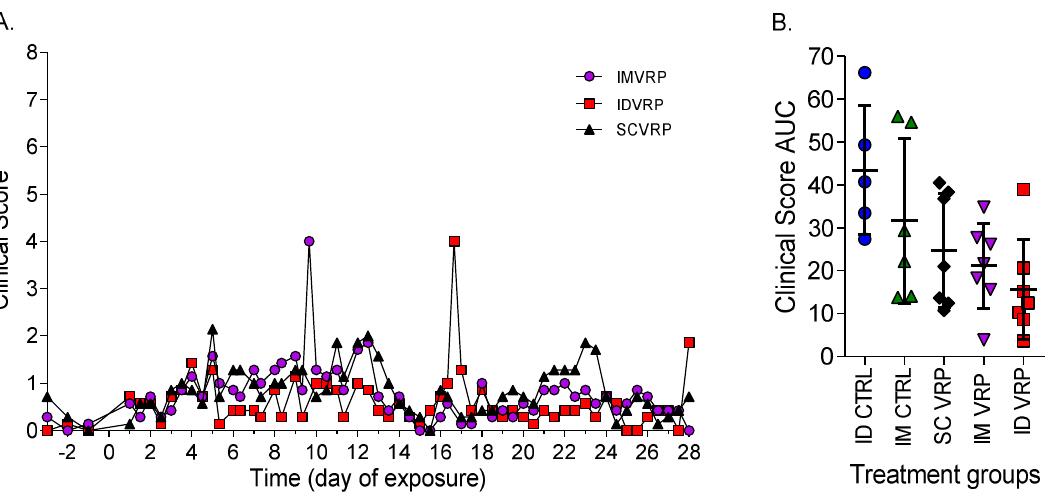
Figure 5. Clinical scores of WEVEE VRP-vaccinated NHPs. ( A ) Average clinical scores for ID, IM, and SC VRP-vaccinated NHPs ( n = 7/group). All vaccinated NHPs survived to study end-point. The peak for the IM group on day 9 post exposure (PE) and the ID group on day 15 PE are due to one NHP with a score of 6 at each time point. ( B ) Area under the curves for each NHP per treatment group. Dots represent individual animals; bars represent the mean; error bars represent ± standard deviation.